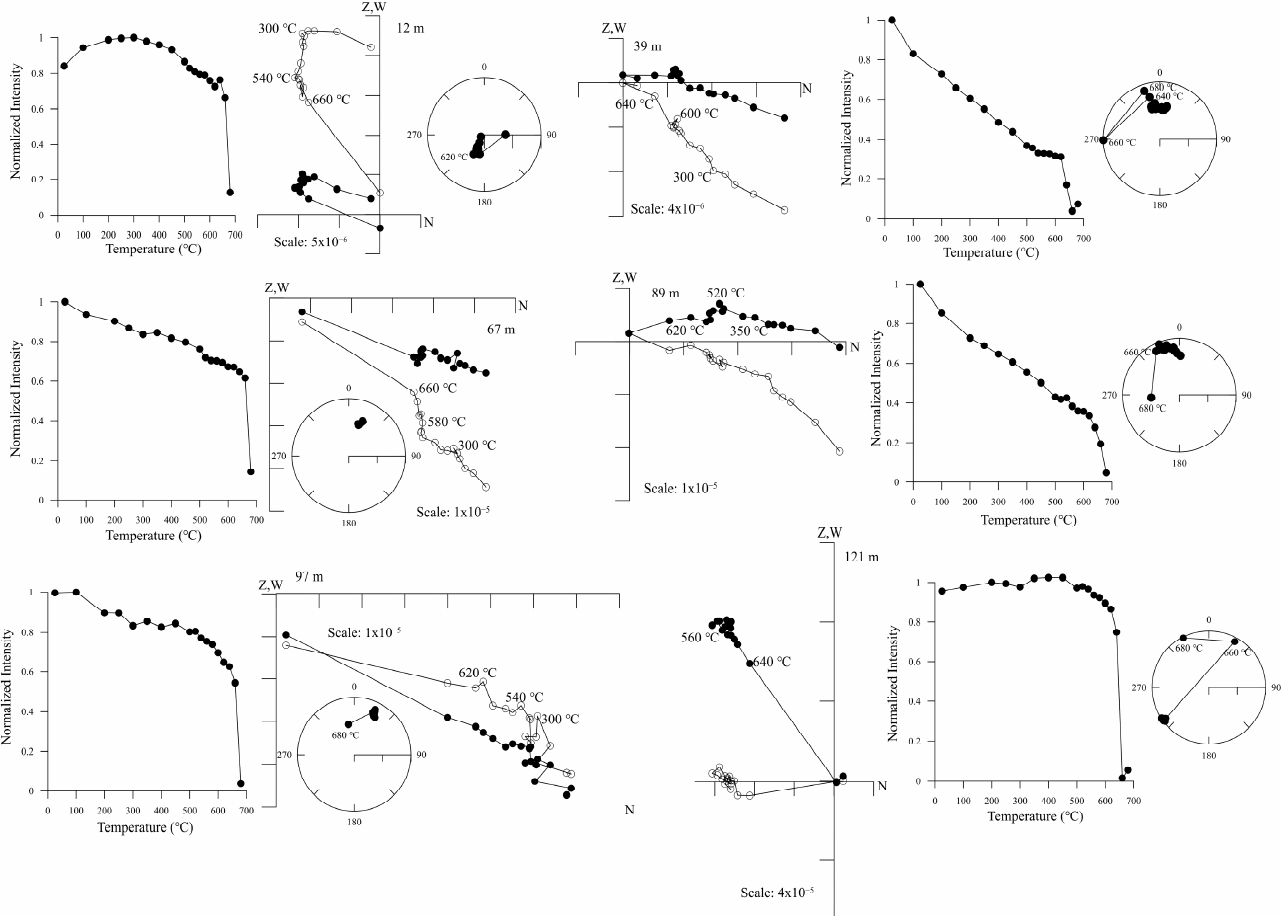
Figure 6. Orthogonal projections and magnetic intensity of the thermal demagnetization of the NRM of representative specimens from the TTH-D section. Solid (open) dots represent projections onto the horizontal (vertical) plane.